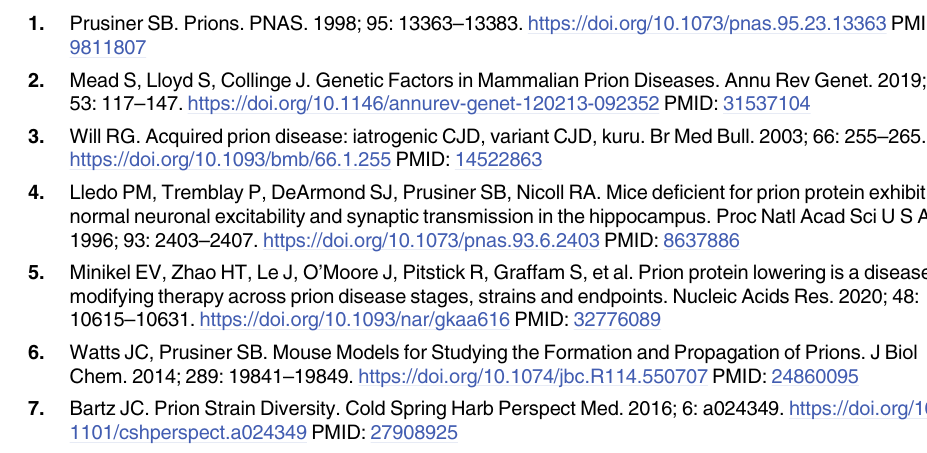
S1 Tables. Table A: All prion NHP reports from which data were evaluated for inclusion in the present study. Table B: The full prion-infected NHP dataset used for analysis. Table C: All NHP species used in the studies evaluated for inclusion. Supplemental